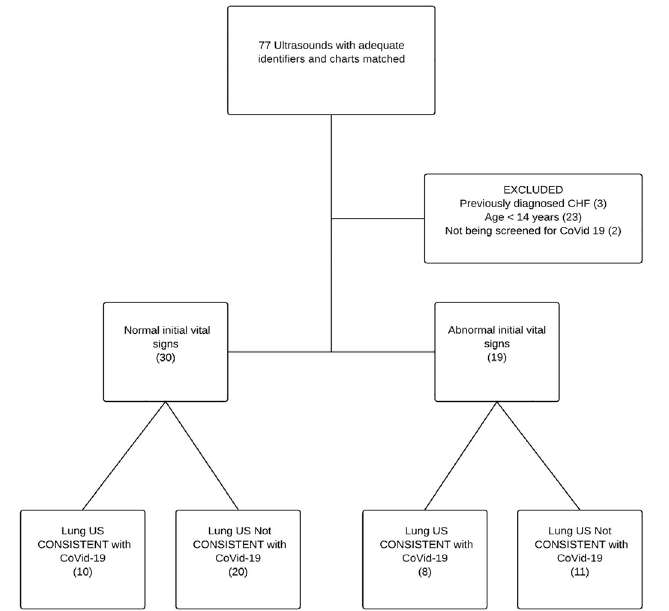
Figure. This figure shows patient flow through the study. Given the clinical context of evaluating suspected COVID-19 the presence or absence of lung ultrasound findings consistent with viral pneumonitis was interpreted as consistent with COVID-19. COVID-19, coronavirus disease 2019; US, ultrasound; CHF, congestive heart